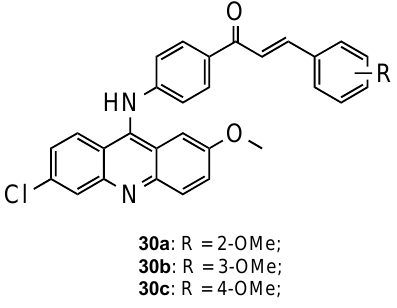
Figure 19. Most promising compounds 30 developed by Prajapati and co-workers [42].